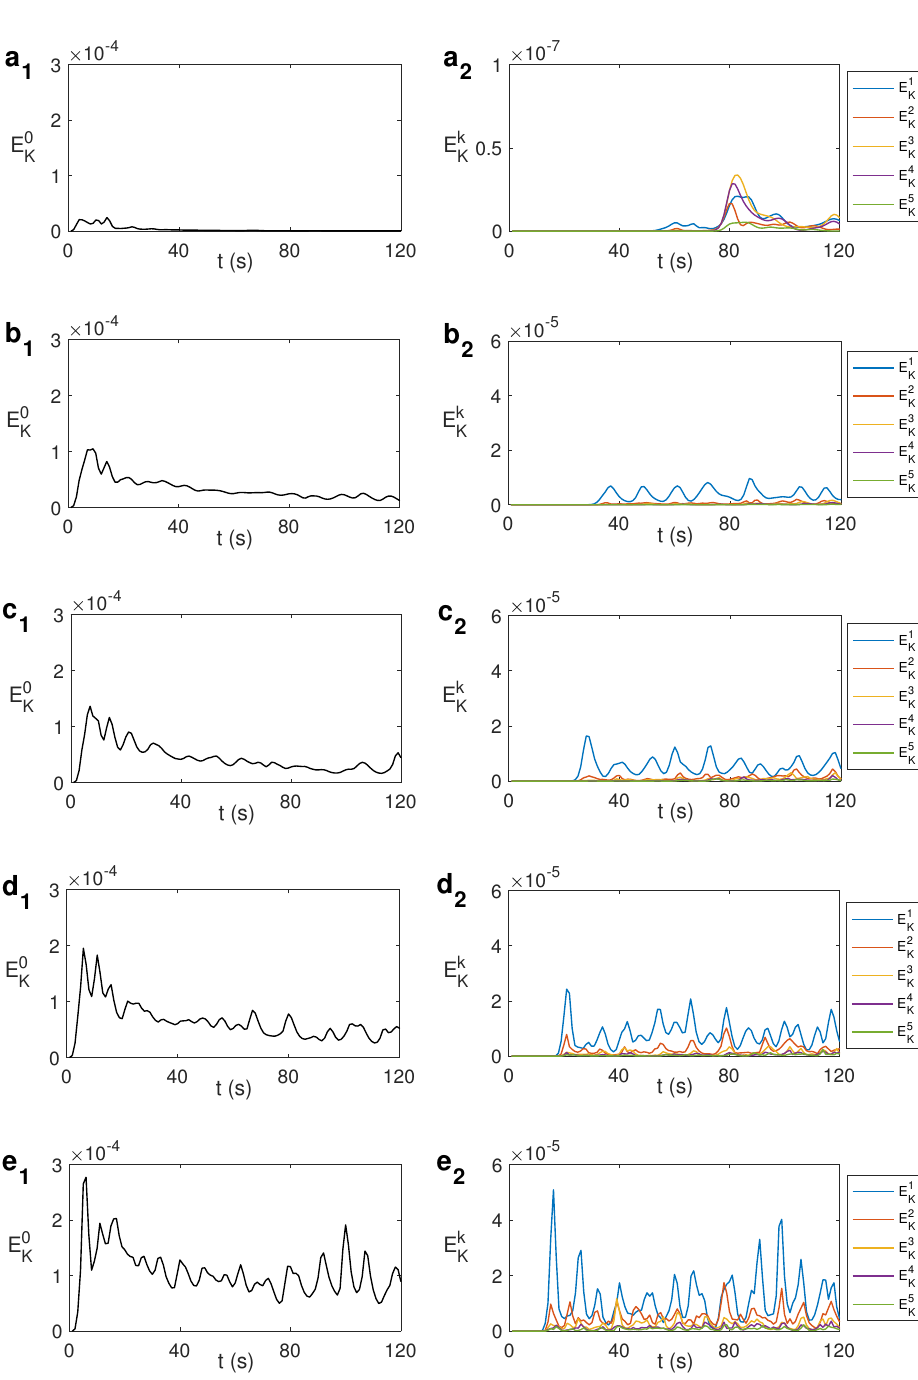
Figure 3. Spectral decomposition of the kinematic energy E K with the azimuthal wave number k for different values of Ω . ( a ) Ω = 0 s − 1 . ( a 1 ) Kinematic energy for k = 0; ( a 2 ) Kinematic energy for k ≥